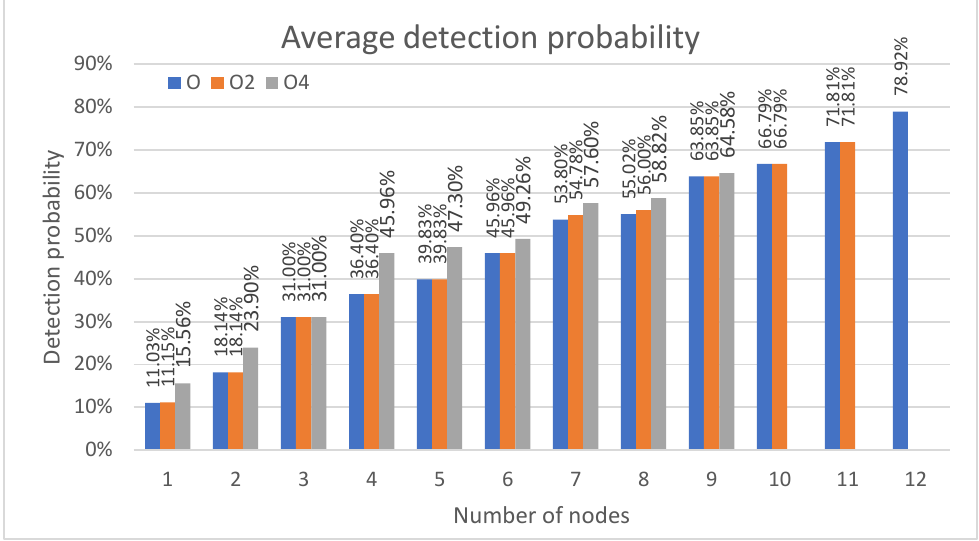
Figure 6. Comparing mean detection probability from the objectives O 2 , O 4 and O.